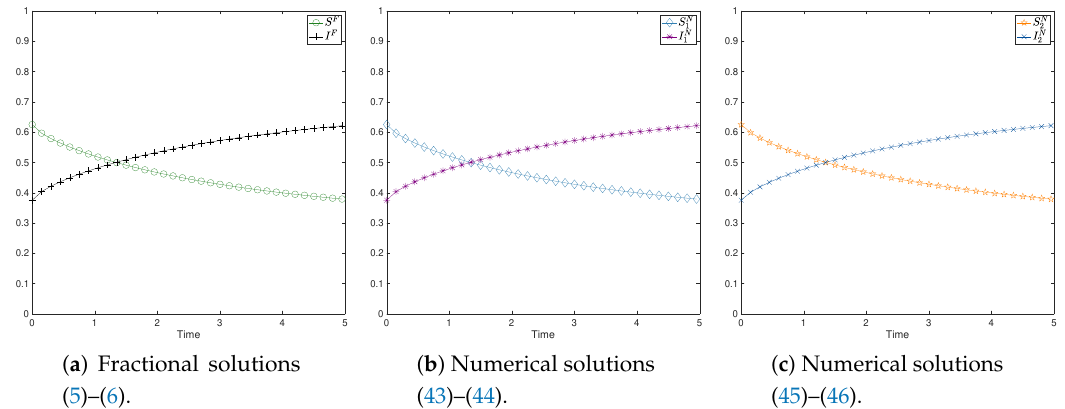
Figure 2. Comparison between the explicit and numerical fractional solutions to (1) with α = 0.7.